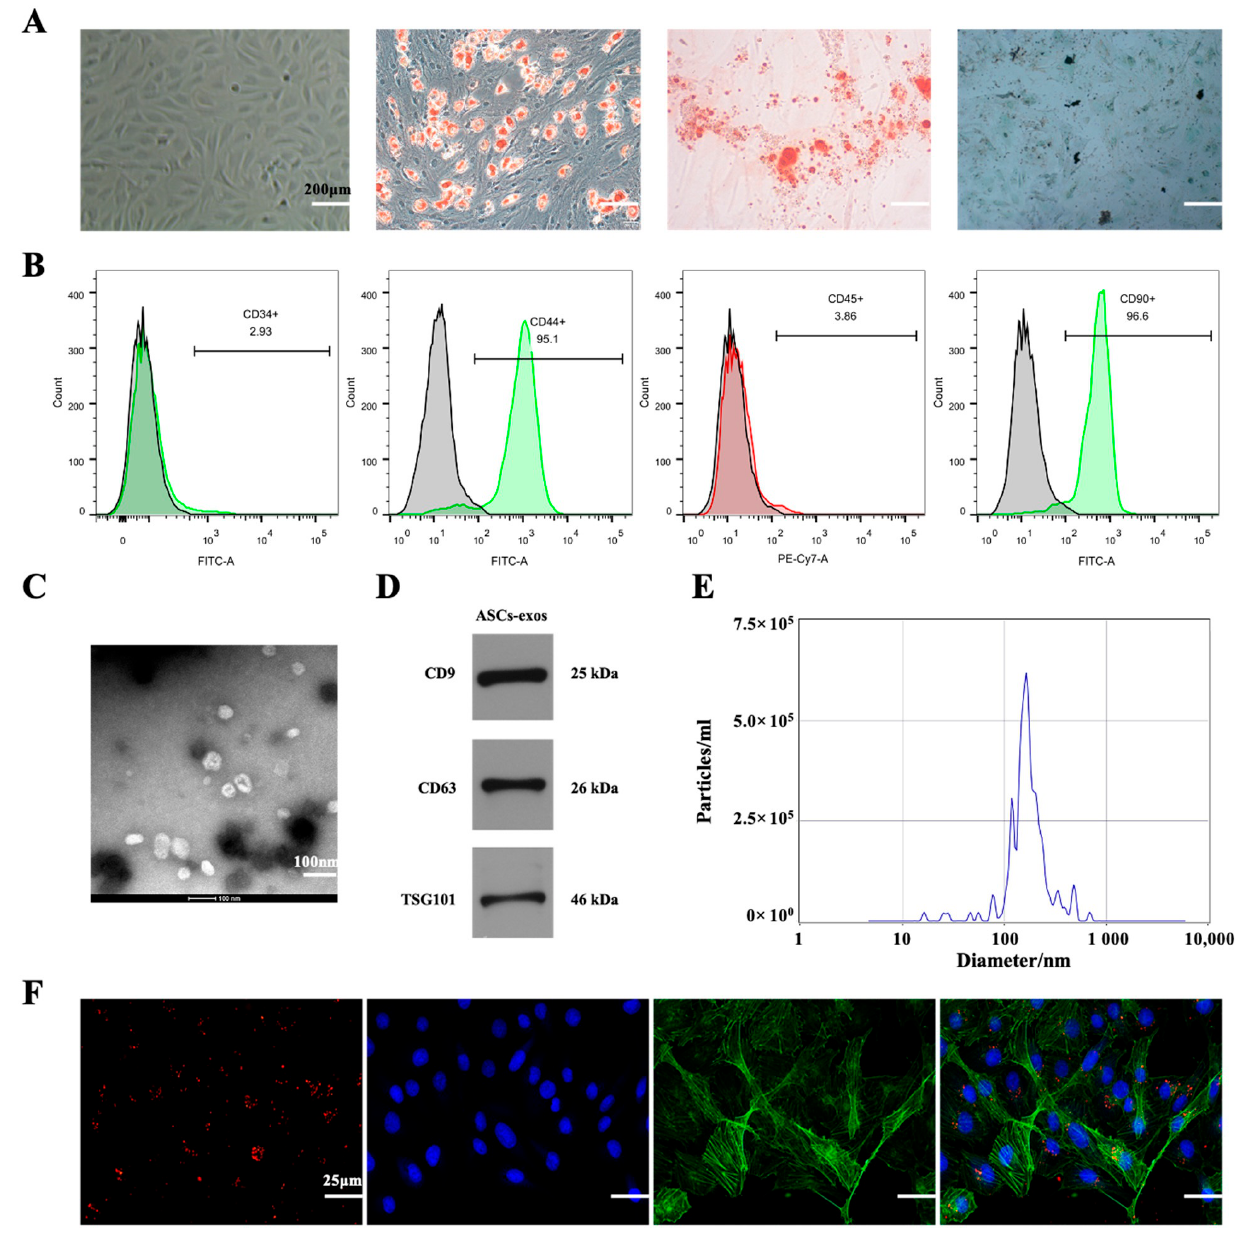
Figure 1. The identification of ASCs and ASCs-exos. ( A ) ASCs showed spindle-like morphology and multipotent differentiation potential, including adipogenic, osteogenic and chondrogenic differentiation. ( B ) ASCs were positive for CD44 and CD90, but negative for CD34 or CD45. ( C ) The observation of morphology using TEM. ( D ) The identification of particle size distributions using DLS. ( E ) Specific surface markers of exosomes including CD9, CD63 and TSG101 were identified using Western blotting. ( F ). The exosomes were marked with red fluorescence dye PKH26 and co-cultured with BMSCs; red fluorescence represents exosomes internalized by BMSCs.